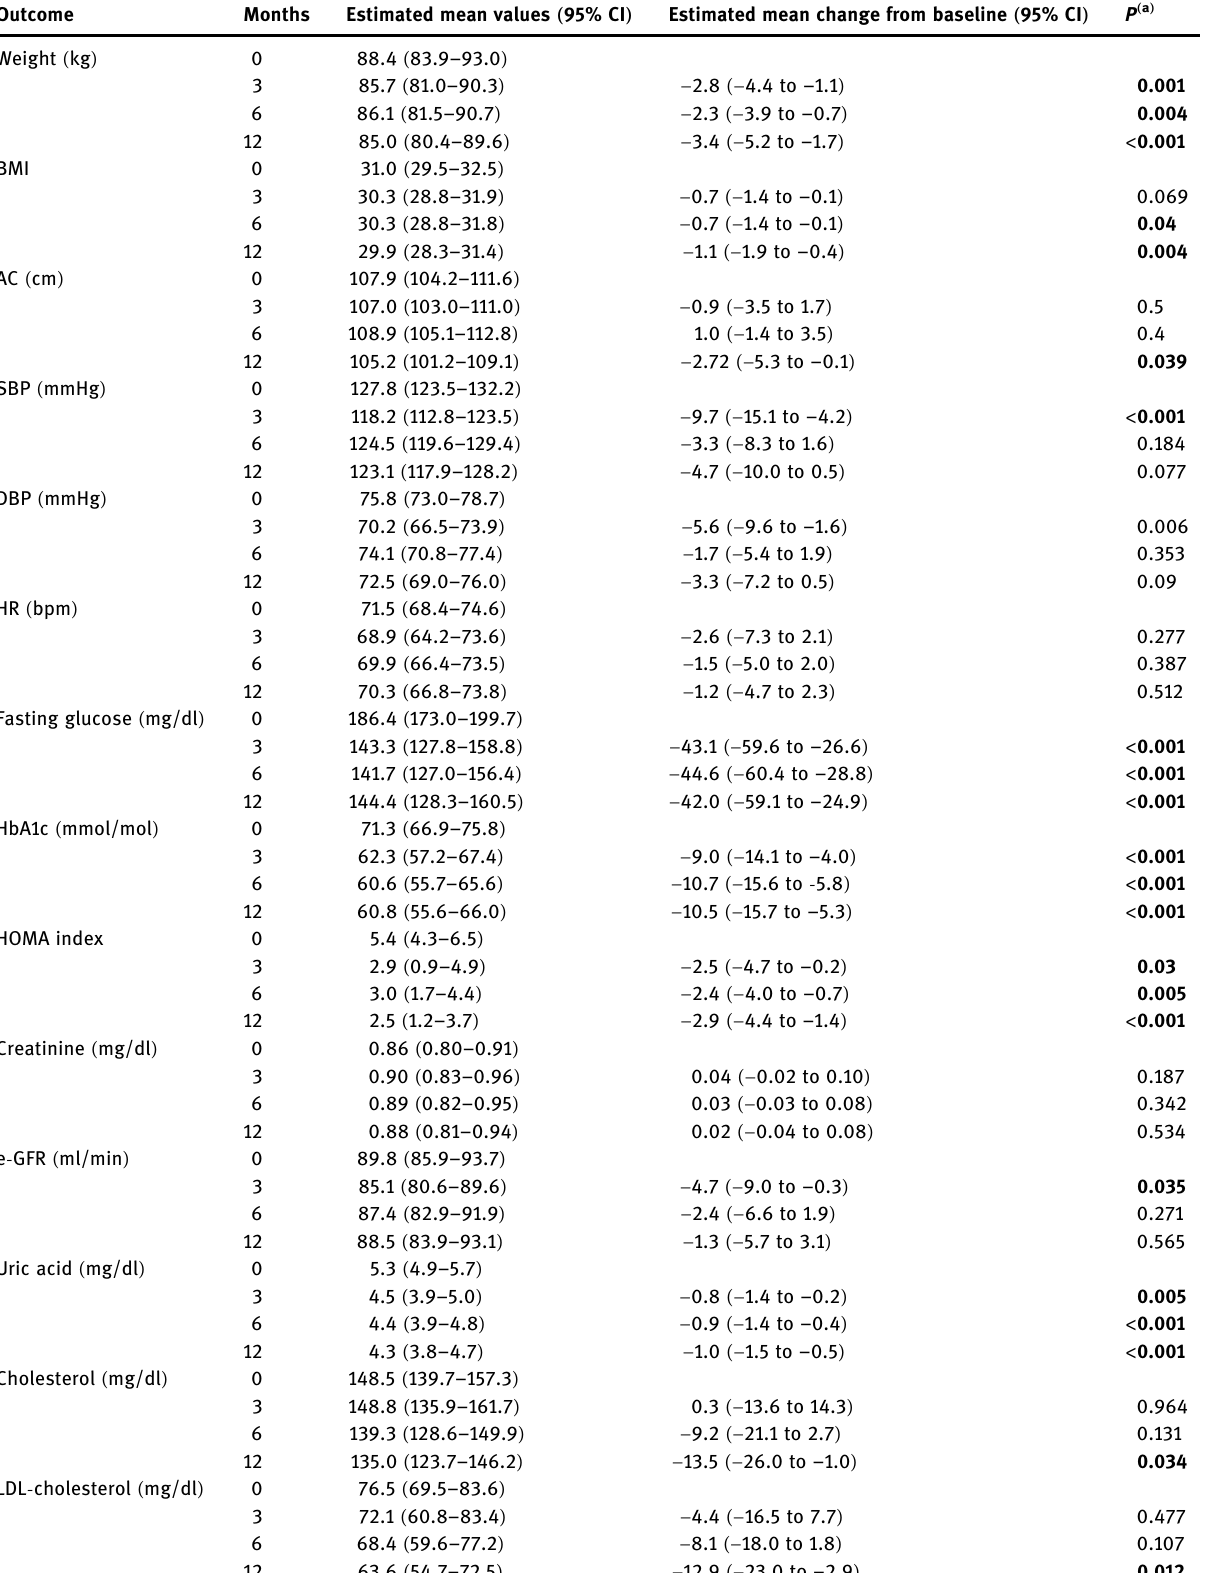
Table 3: Time trends of clinical parameters in patients treated with SGLT2i